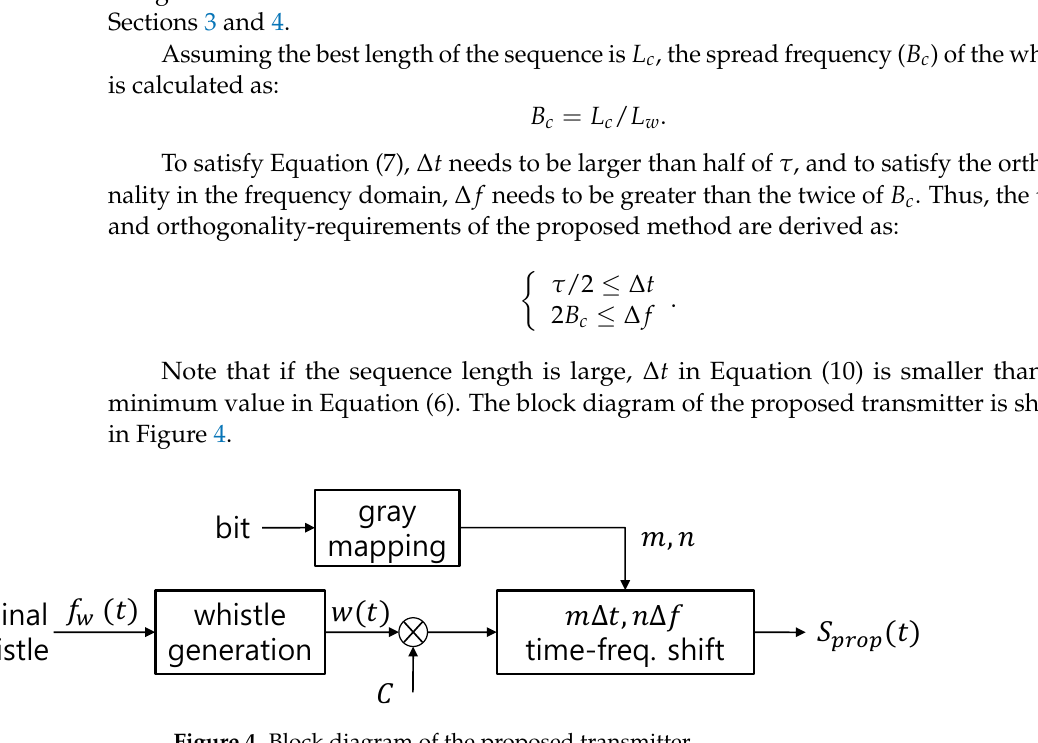
Figure 4. Block diagram of the proposed transmitter.